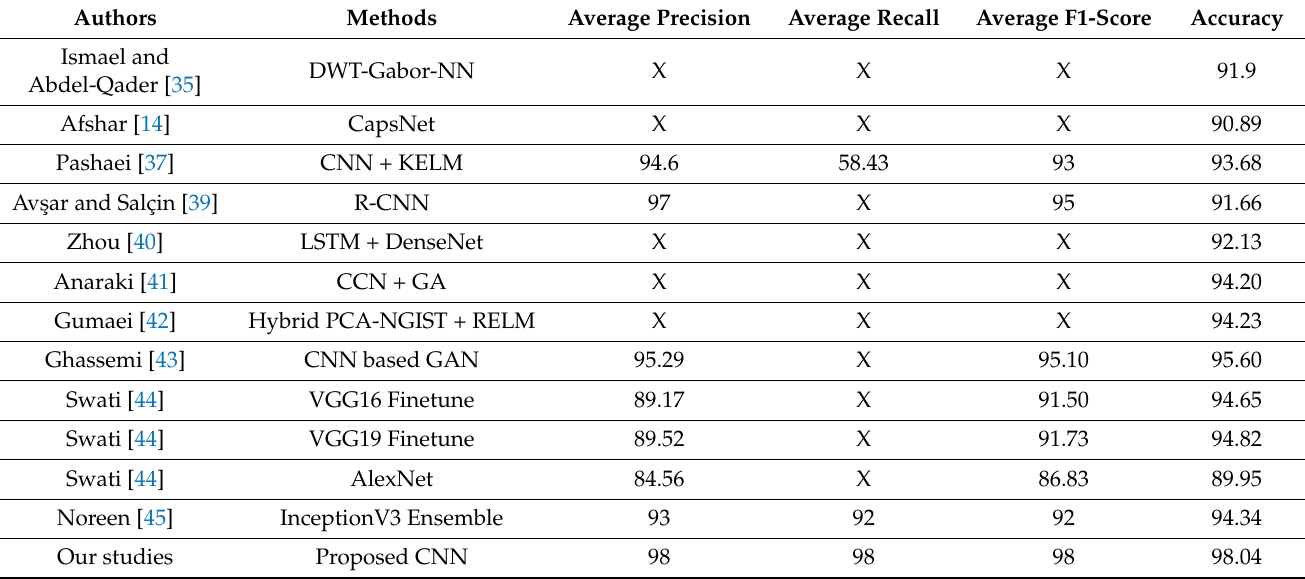
Table 1. Comparison between the proposed model and previous related